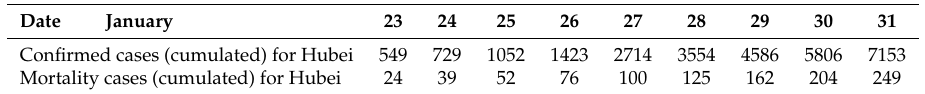
Table 3. Reported case data 23–31 January 2020, reported for Hubei Province by the Wuhan Municipal Health Commission [6].